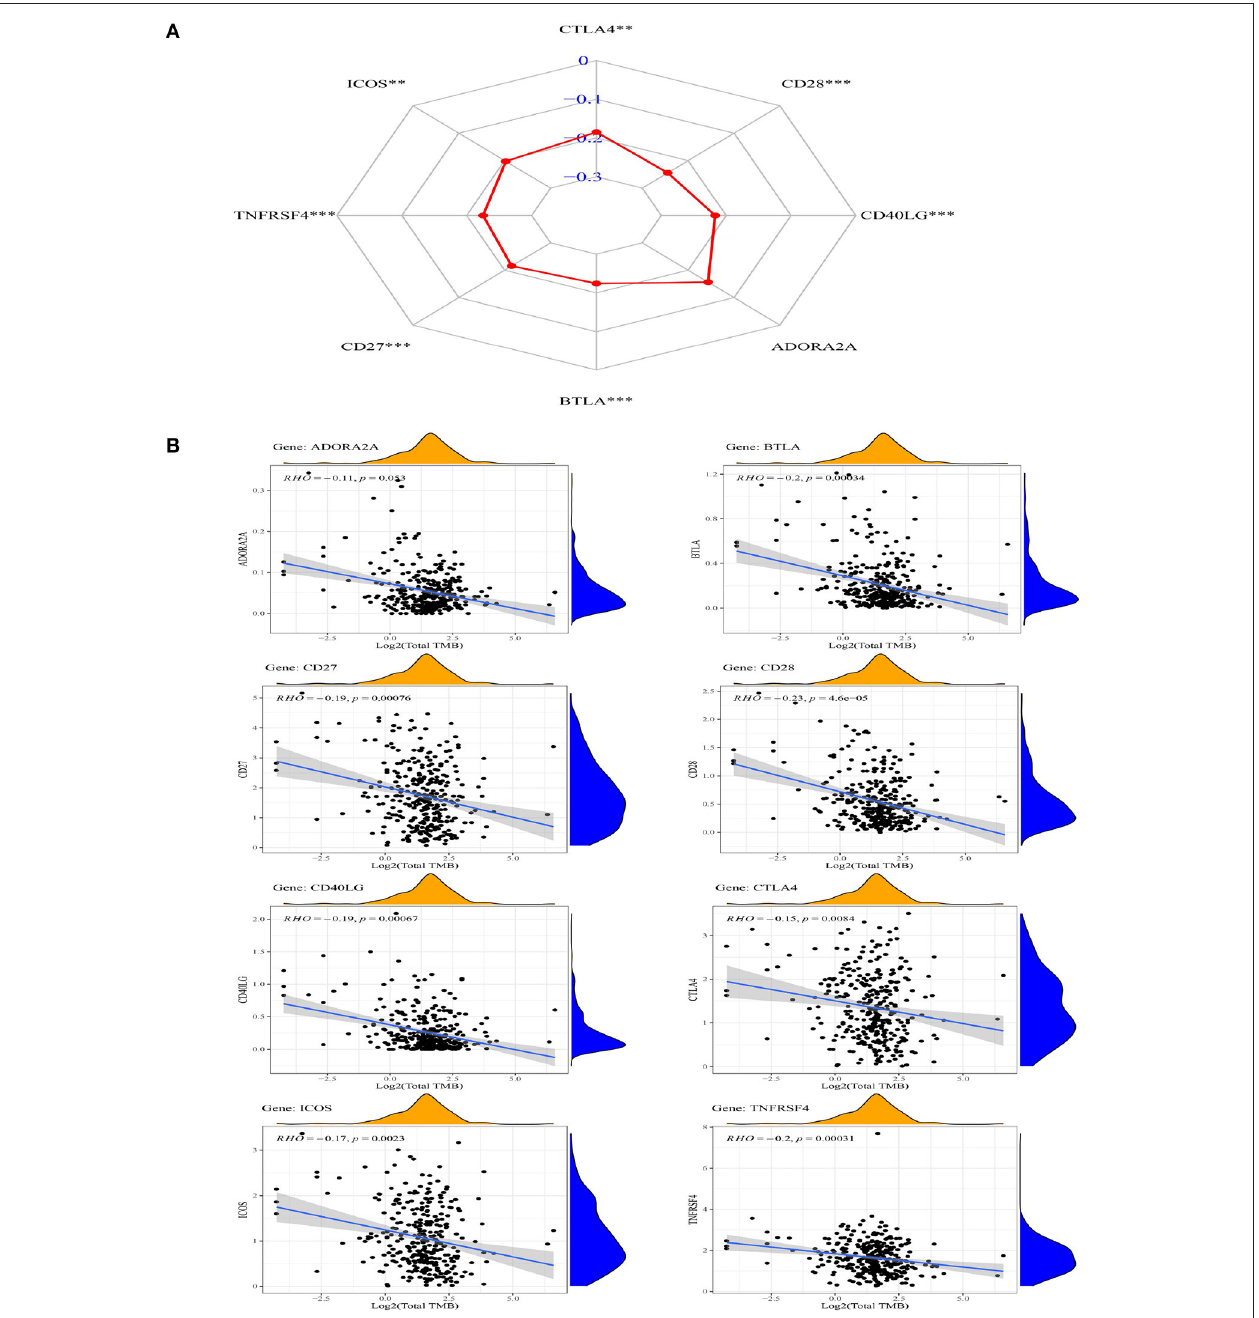
FIGURE 5 | The radar chart (A) and scatter plot (B) showing the relationship between the eight ICGs positively correlated with CD274 (CTLA4, CD28, CD40LG, ADORA2A, BTLA, CD27, TNFRSF4, and ICOS) and TMB. ICGs. Using the mRNA expression data from TCGA and an independent cohort GEO data set, it was shown that eight ICGs (CTLA4, ICOS, TNFRSF4, CD27, BTLA, ADORA2A, CD40LG, and CD28) work synergistically and are positively correlated with CD274. An important finding was that